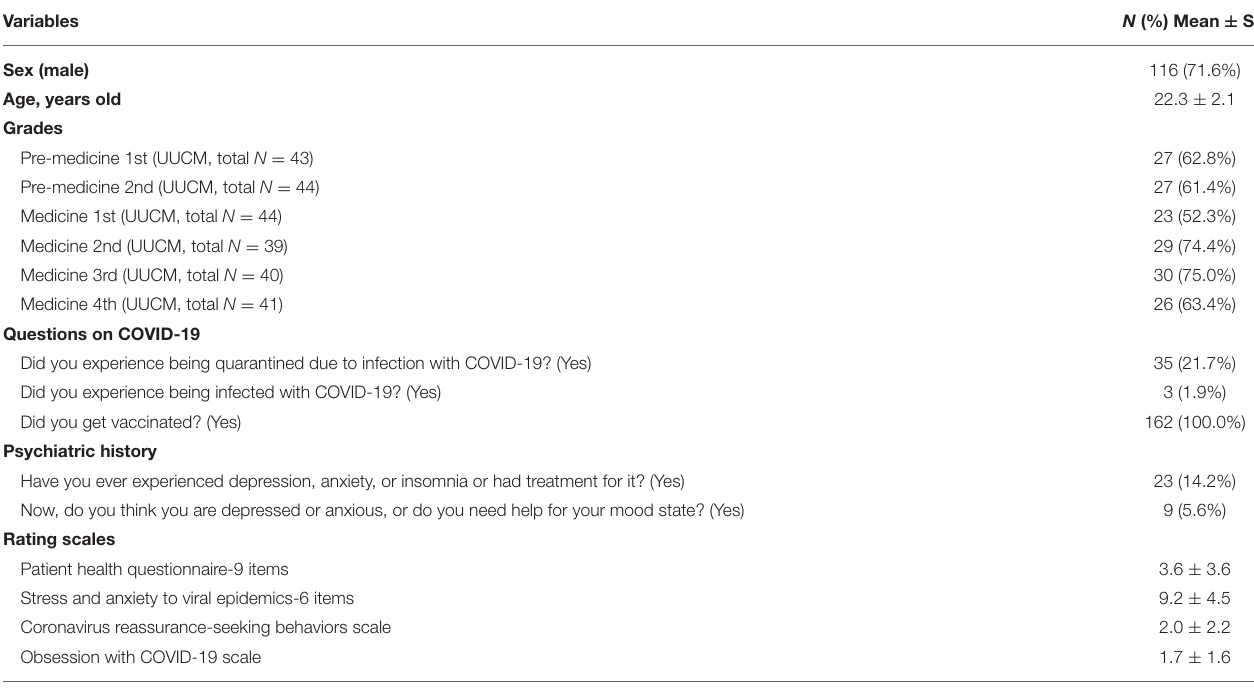
TABLE 1 | Clinical characteristics of participants ( N = 162).